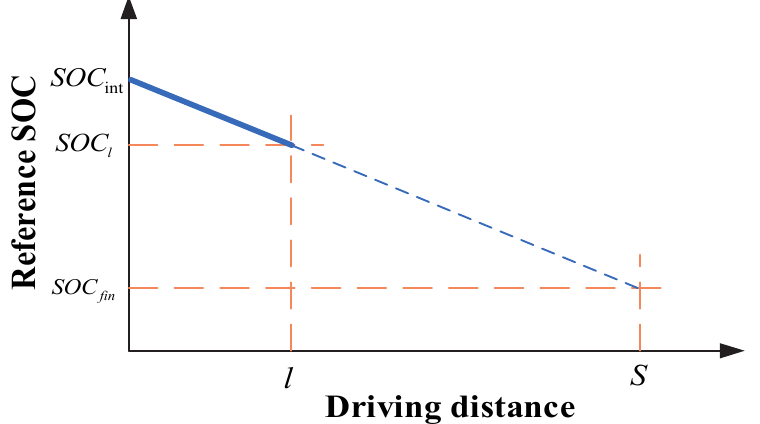
Figure 16. Reference to SOC planning principle.